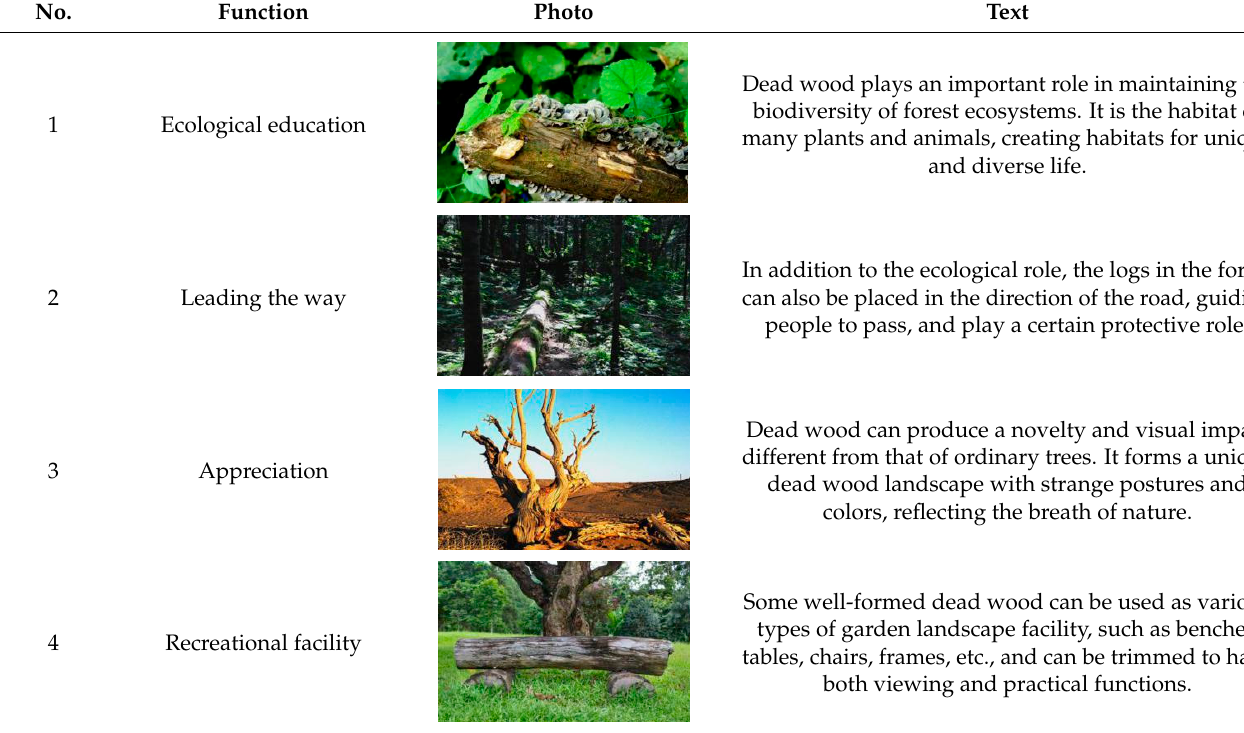
Table 2. Four photos with the descriptive texts that reflect the different functions of dead wood.